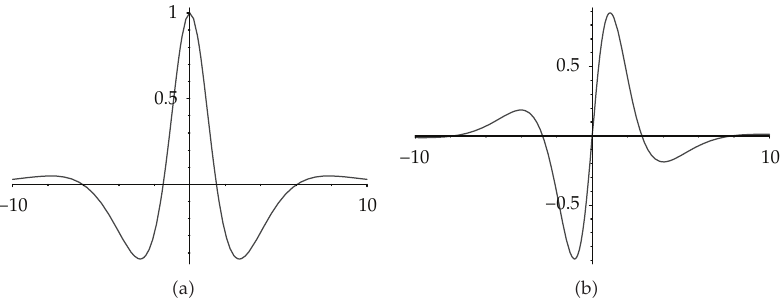
Figure 2: (cid:2) a (cid:3) y (cid:5)